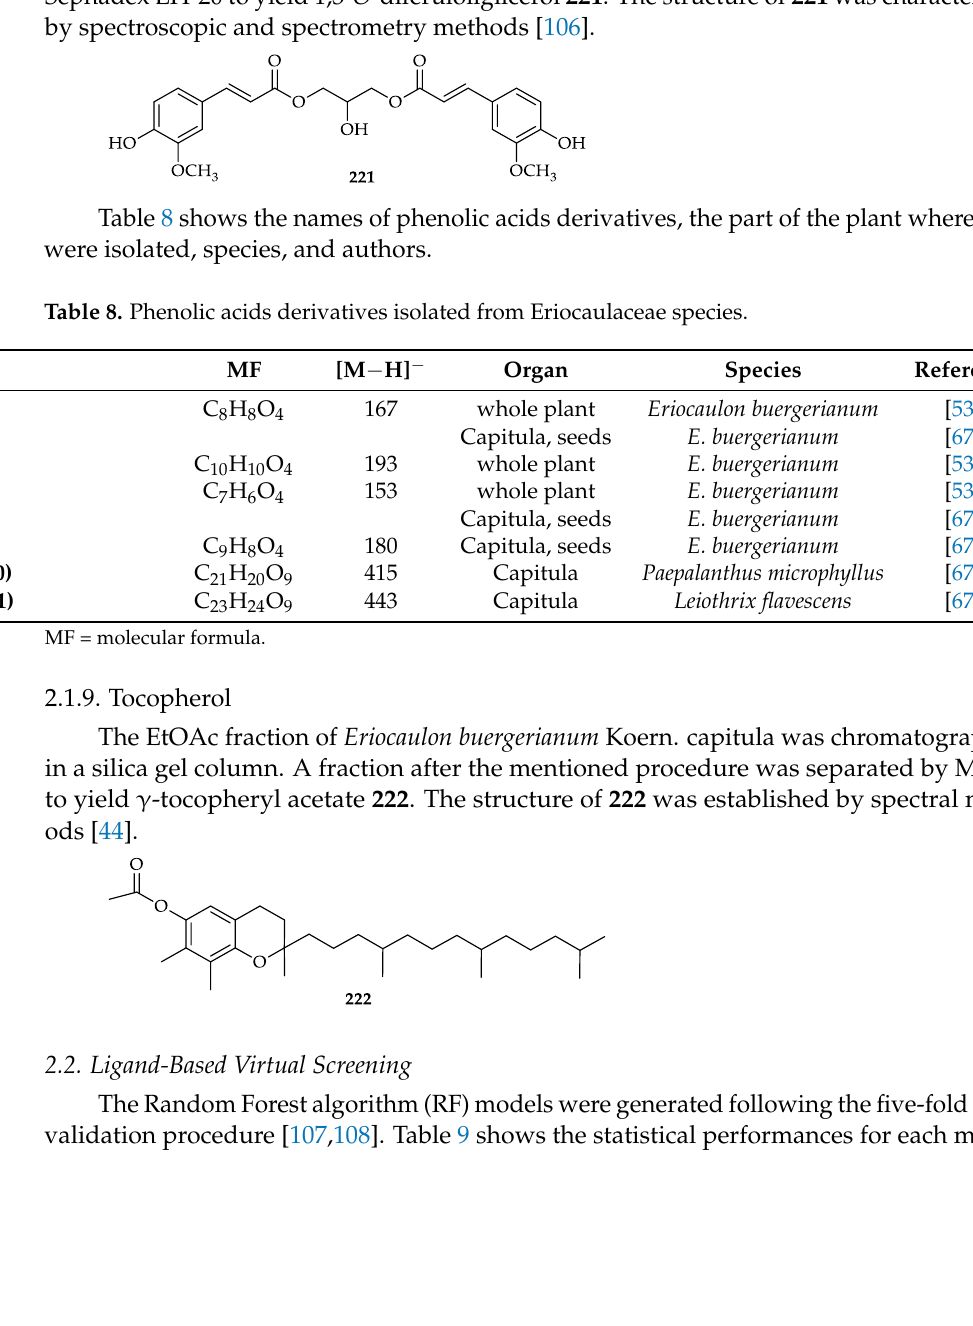
ROC Curve Area under the Curve